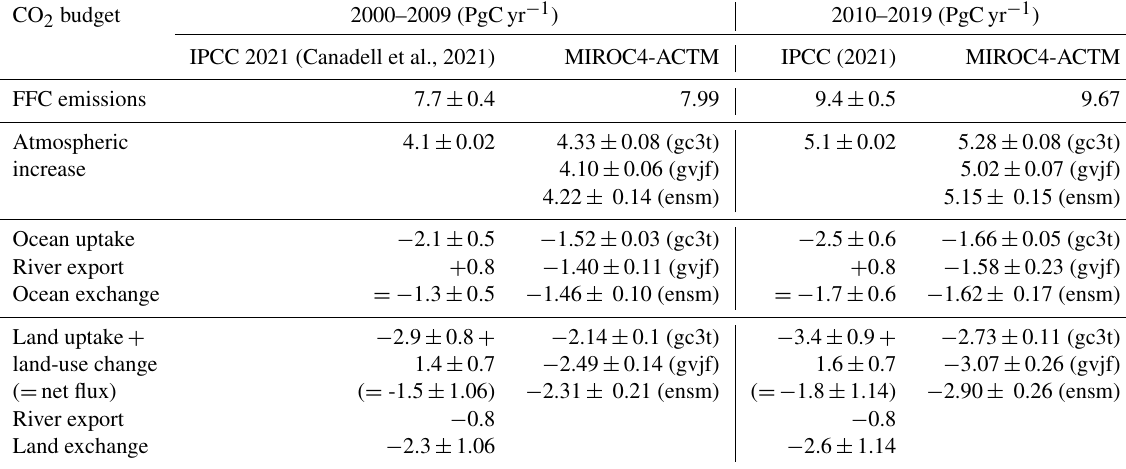
Table 3. Comparison of global total land and ocean CO 2 exchanges estimated by the inversion model with those from the IPCC 2021 (Table 5.1; Canadell et al., 2021). The inversion uncertainties due to PFU and MDU for each inversion family based on priors represent ± 1 σ decadal estimates from the individual inversions. The inversion means and 1 σ standard deviations are shown for two prior flux cases (8 each for gc3t and gvjf) and all 16 ensemble members (ensm). The IPCC global land and ocean CO 2 uptakes are corrected for the river export fluxes. This correction to the net ocean and land uptakes is required because the inverse model estimates fluxes across the land/ocean–atmosphere interface, while the part of the land carbon exchange is exported to the ocean via the rivers and